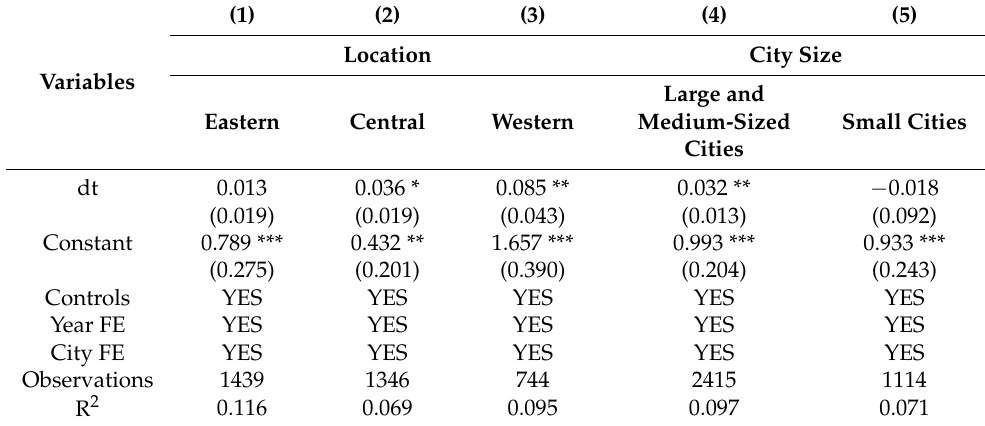
Table 7. Heterogeneity analysis of the effects of FTZ policy on GTFP